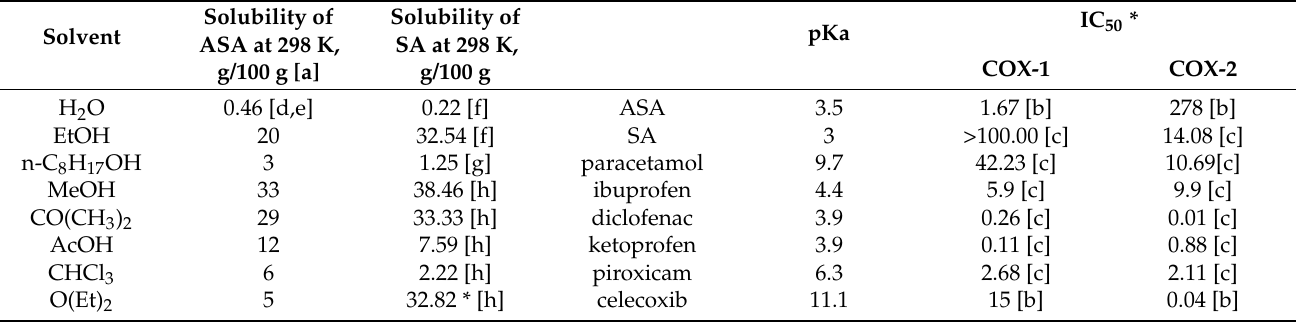
Table 1. The basic physical, chemical and biological properties of ASA compared to selected